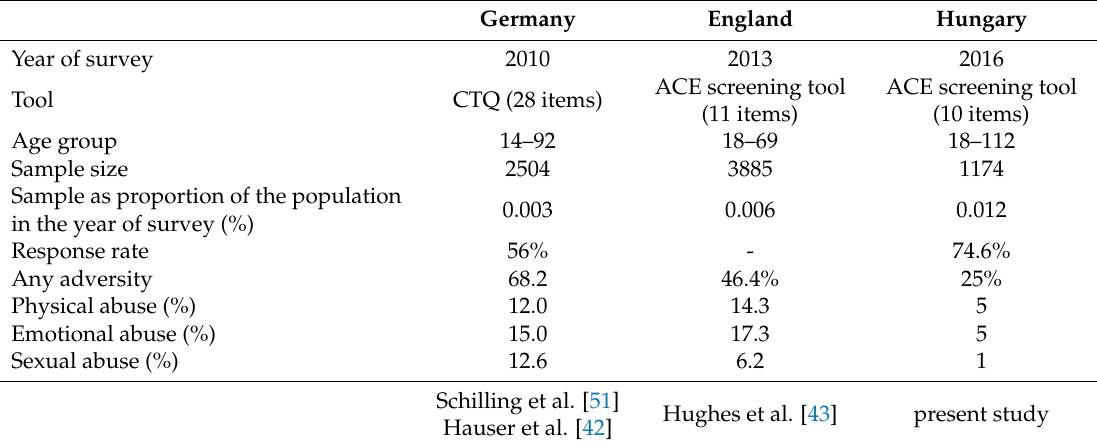
Table 7. Prevalence of some ACEs in representative national